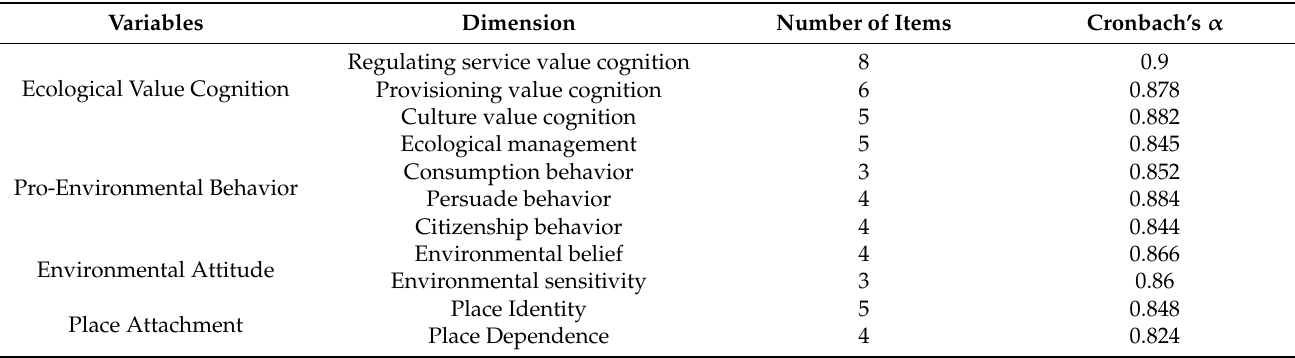
Table 6. Reliability analysis of variables.